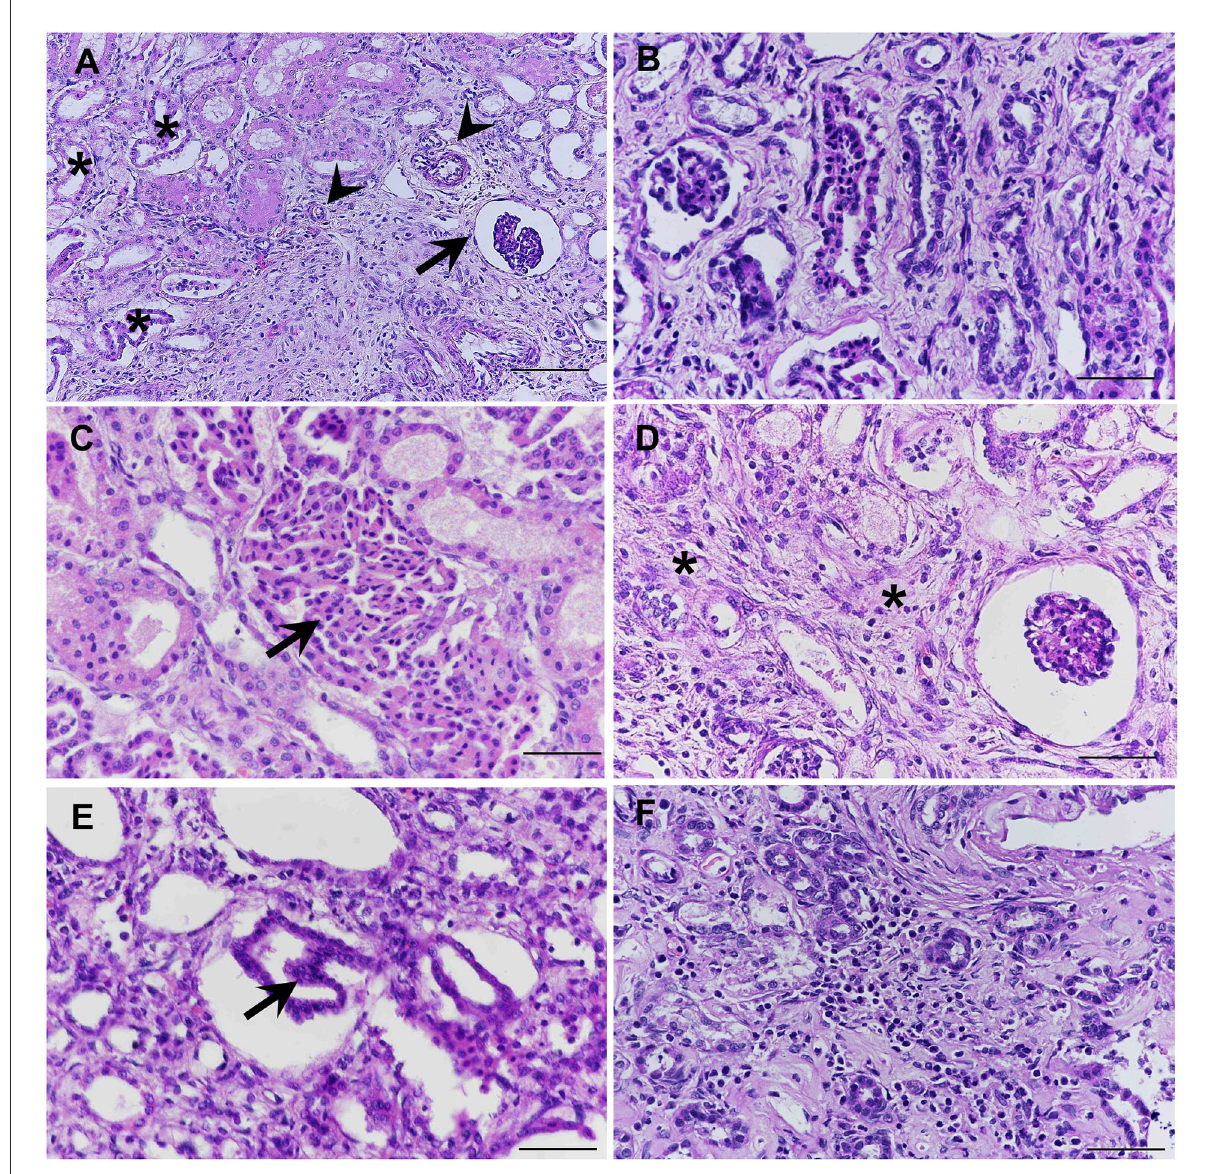
FIGURE2 The immature (fetal) glomeruli (arrow), immature (fetal) tubules (asterisk), and proliferative arterioles (arrow head) were demonstrated in the corticomedullary area of the kidney (A) . Methanephric ducts were characterized by hyperchromatic, pseudostratified, and columnar epithelium, surrounded by interstitial fibrosis and loose mesenchyme (B) . Atypical tubular epithelium (arrow) was characterized by the dilated adenomatoid cuboidal epithelium of collecting ducts (C) . Persistent mesenchyme (asterisks) had been significantly observed in both cortex and medulla (D) . The cortical tubules were infrequently found which were characterized by the hyperplastic (one to three layers into the inner lumina) of the epithelial cells (arrow) (E) . Mild to moderate lymphoplasmacytic interstitial nephritis was displayed (F) (H&E stain, scale bar = 50 µ m).